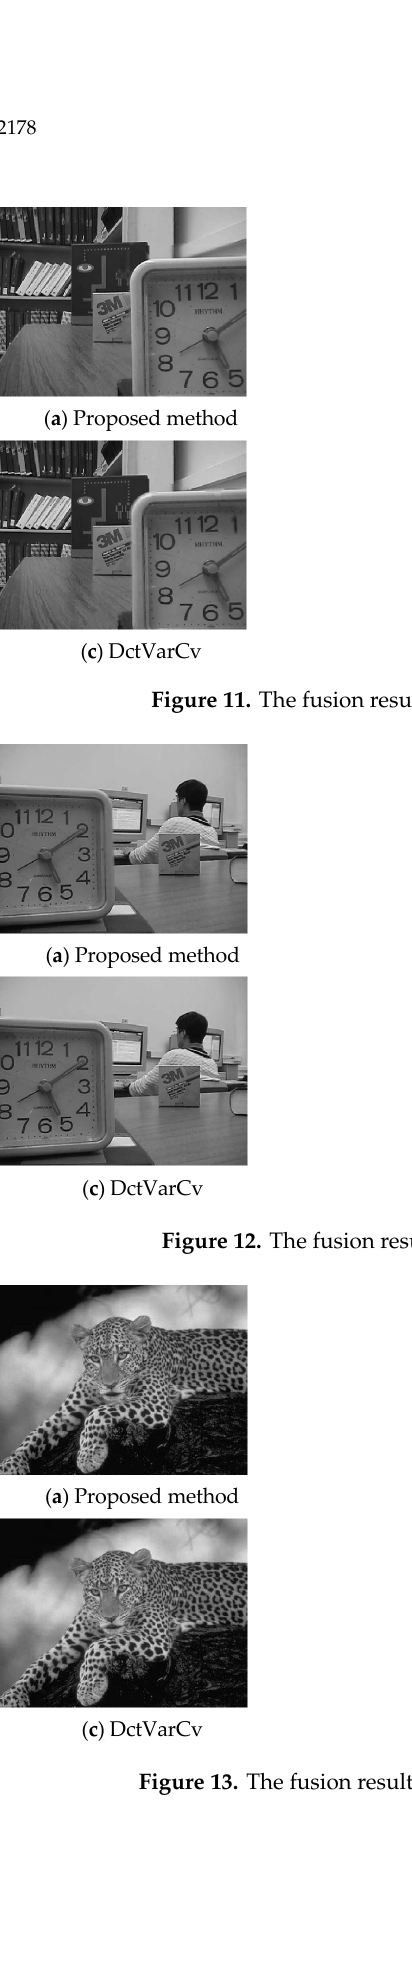
( d ) SAIF Figure 14. The fusion result of the toy image.